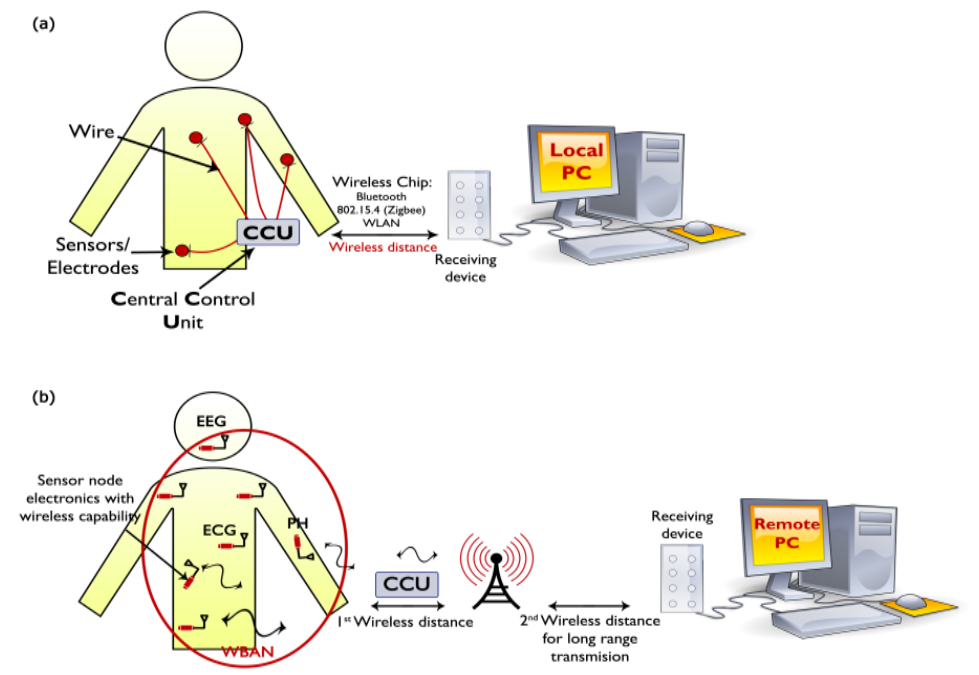
Figure 2. A WSN system: ( a ) wired system and ( b ) wireless system. Adapted with permission from